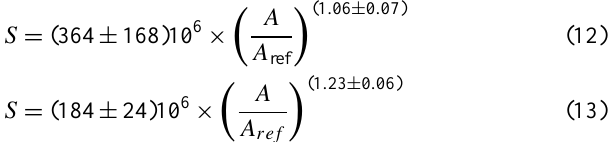
vestigate the impact of human activities on erosion and sed- iment yields through history. The Rhine catchment (Fig. 2) has a size of ∼ 185 000 km 2 with a main river channel length of ∼ 1320 km and drains large parts of the area between the European Alps and the North Sea. It has a complex topog- raphy where the elevation ranges between − 180 and 1967 m with a mean topographical percent slope of 0.07, where per- cent slopes can go up to 1.2. It consists of two large sedi- mentary catchments (i.e., upper Rhine Graben and the lower Rhine Embayment–southern North Sea Basin) that serve as large floodplain sinks for sediment and some upland areas, such as the Black Forest and the European Alps, that serve as major sediment production